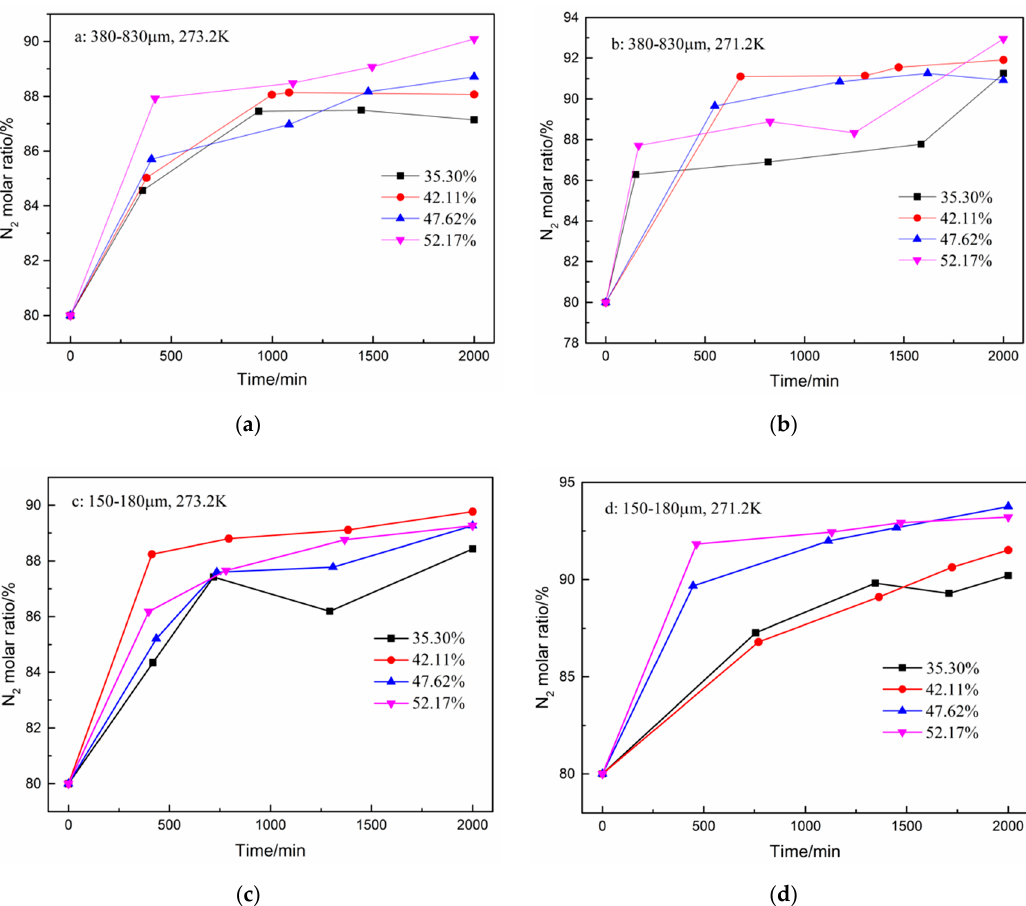
Figure 5. N 2 molar ratio in gas phase after hydrate formation under different conditions. ( a ): 380–830 μ m, 273.2 K; ( b ): 380–830 μ m, 271.2 K; ( c ): 150–180 μ m, 273.2 K; and ( d ): 150–180 μ m, 271.2 K.